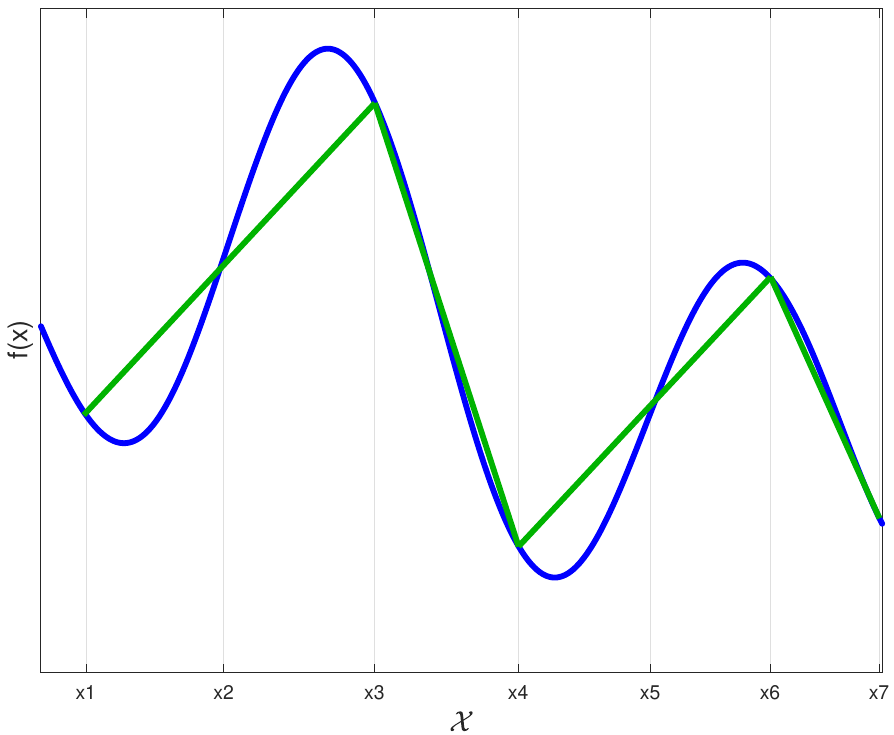
Figure 5. It can be seen that the uniform sampling error increases with the magnitude of the